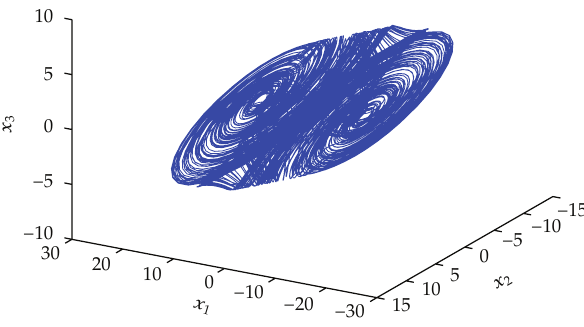
Figure 3: Phase portraits of the autonomous system (cid:2) 4.10 (cid:3)